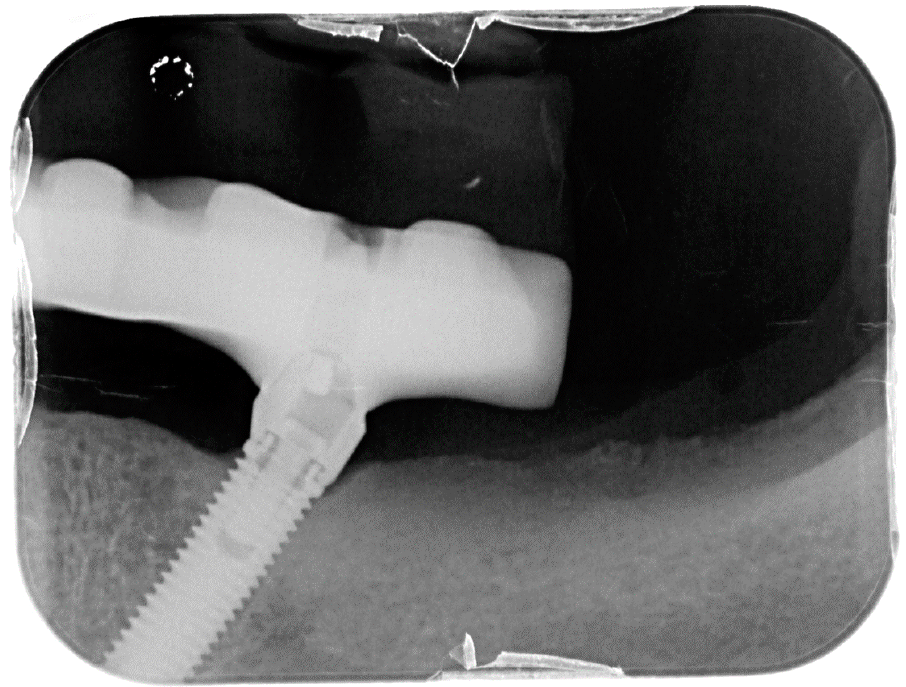
Figure 13. X-ray of 3.5 dental implant in patient in 6 months after treatment.